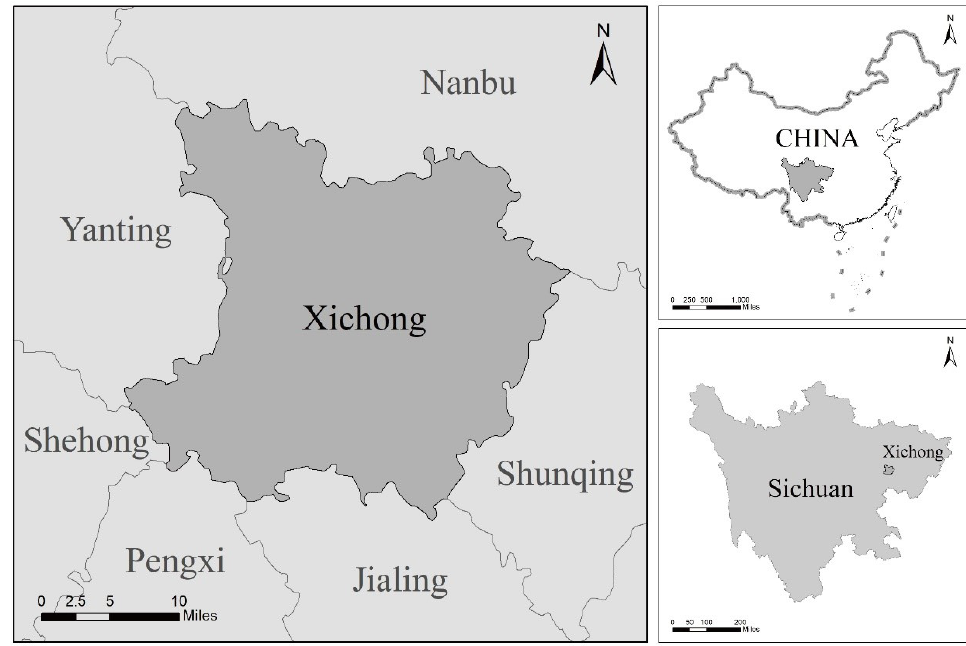
Figure 2. The location map of